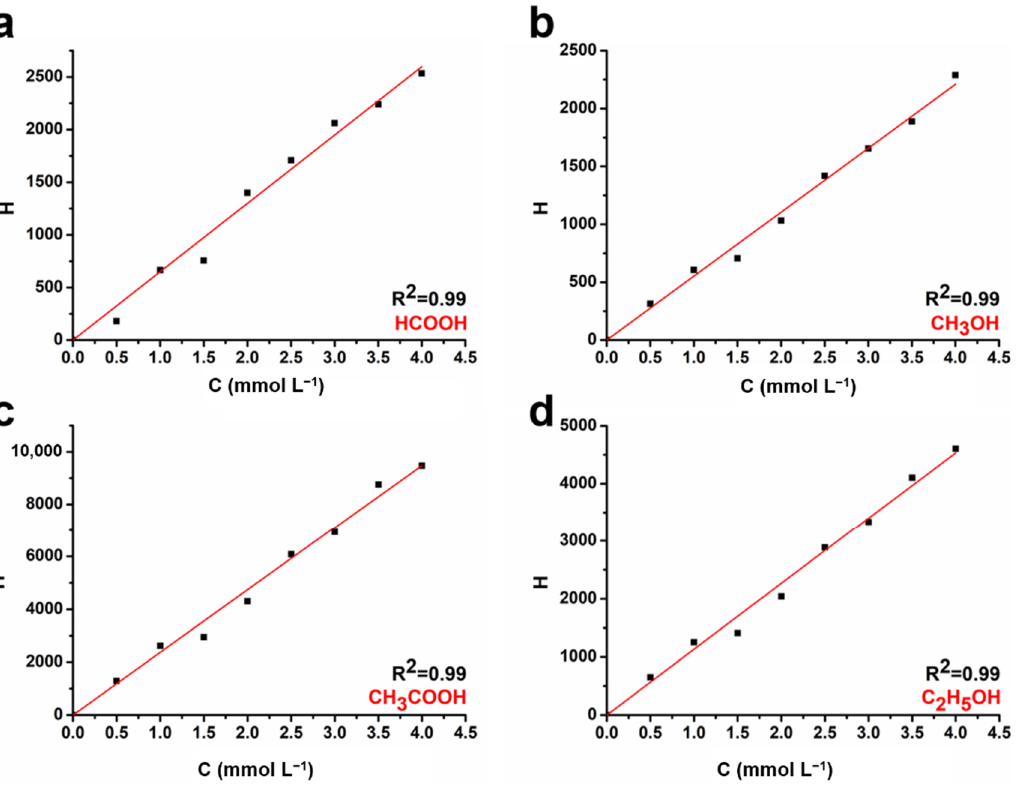
Figure 18. Standard curve lines of ( a ) HCOOH, ( b ) CH 3 OH, ( c ) CH 3 COOH, ( d ) C 2 H 5